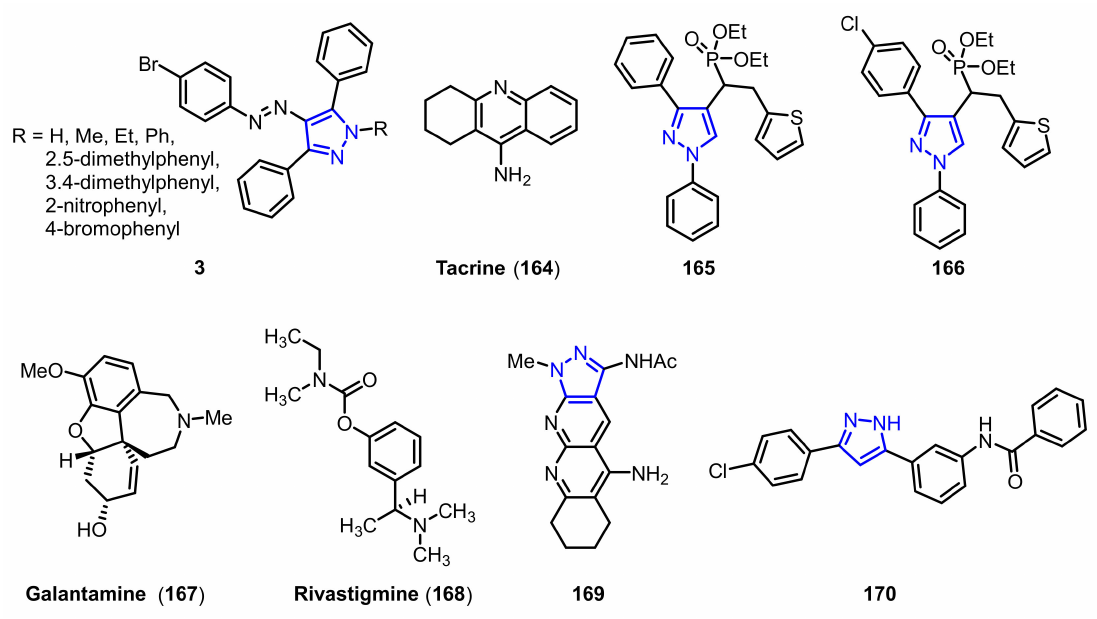
Figure 8. Chemical structures of cholinesterase